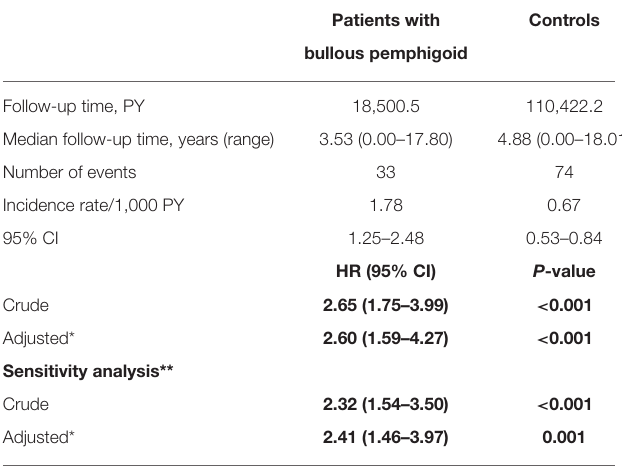
TABLE 1 | Descriptive characteristics of the study population. Characteristic